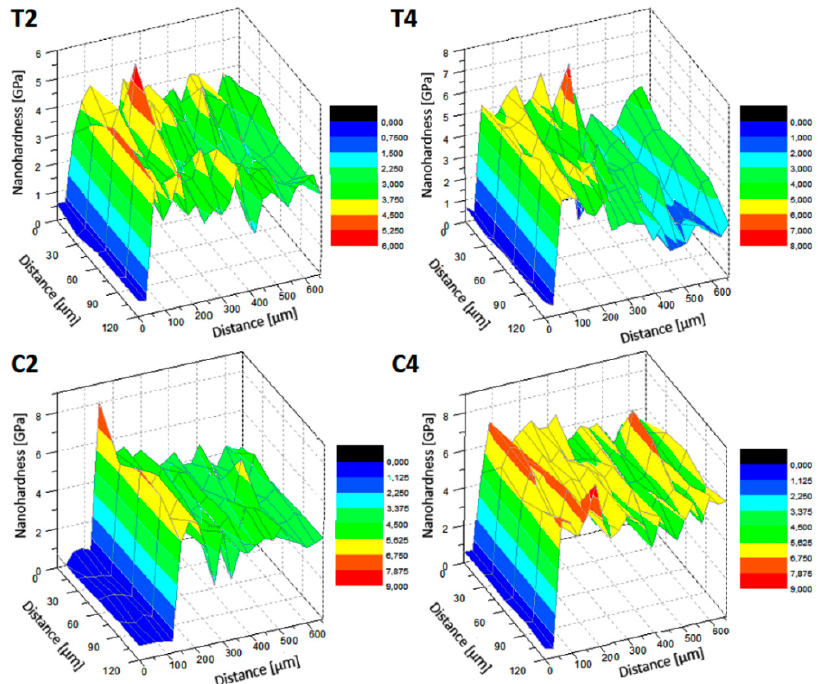
Figure 9. 3D distribution of nanohardness for tested samples T2, T4, C2 and C4.